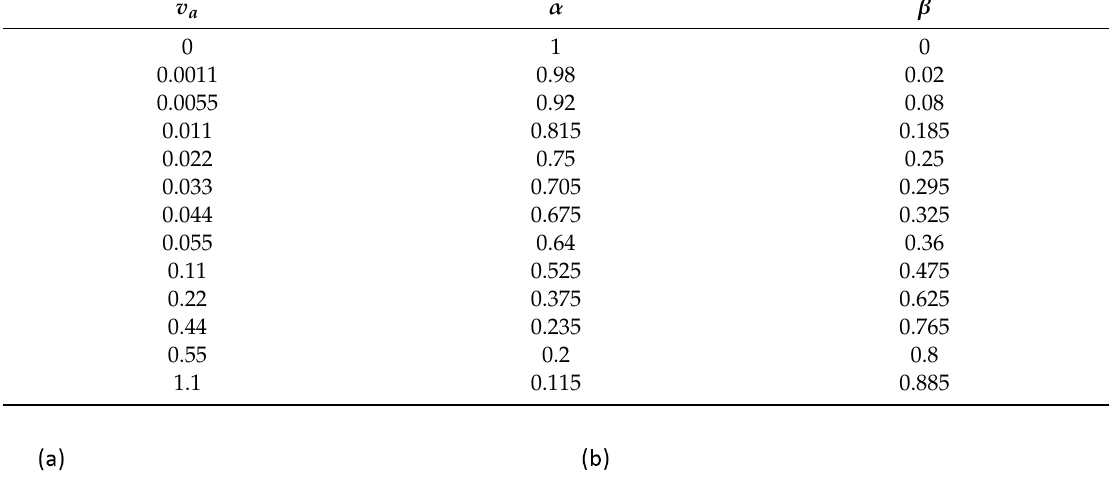
Table 2. Relationship between arithmetic average groundwater flow velocity and parameters α and β .